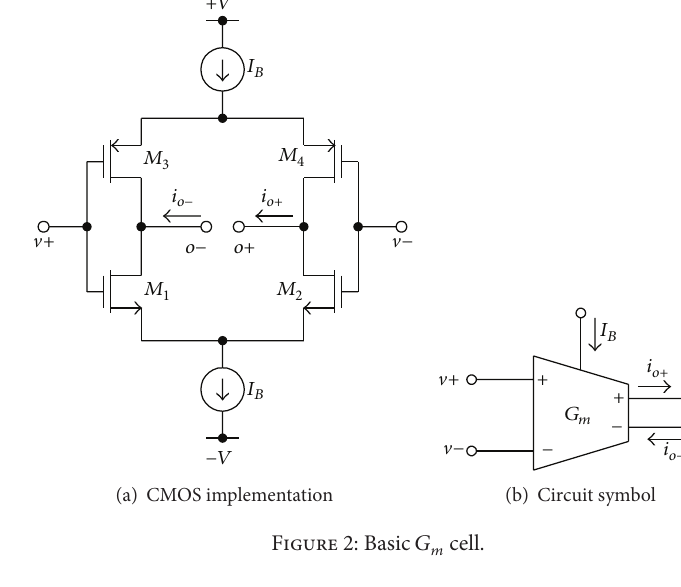
Figure 2: Basic 𝐺 𝑚 cell.